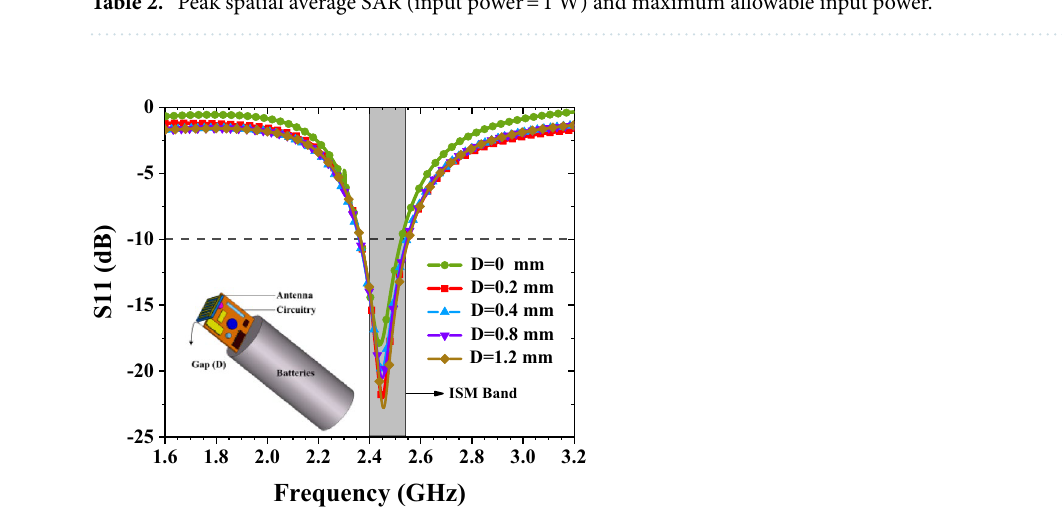
Figure 13. Coupling effects due to metallic components of the system on the implantable antenna